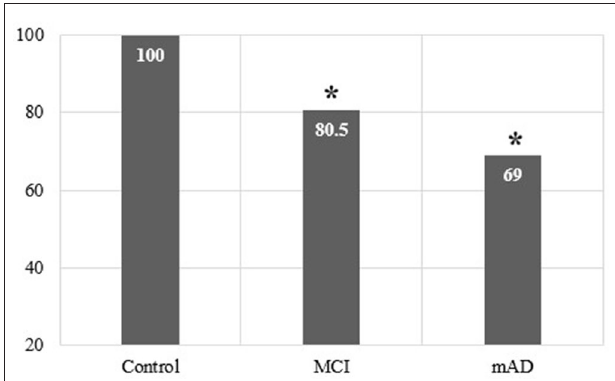
FIGURE 2 | Percentages of correct responses in picture-naming task for control group, individuals with MCI and individuals with mAD. The asterisk indicates significant effects ( p < 0.05).